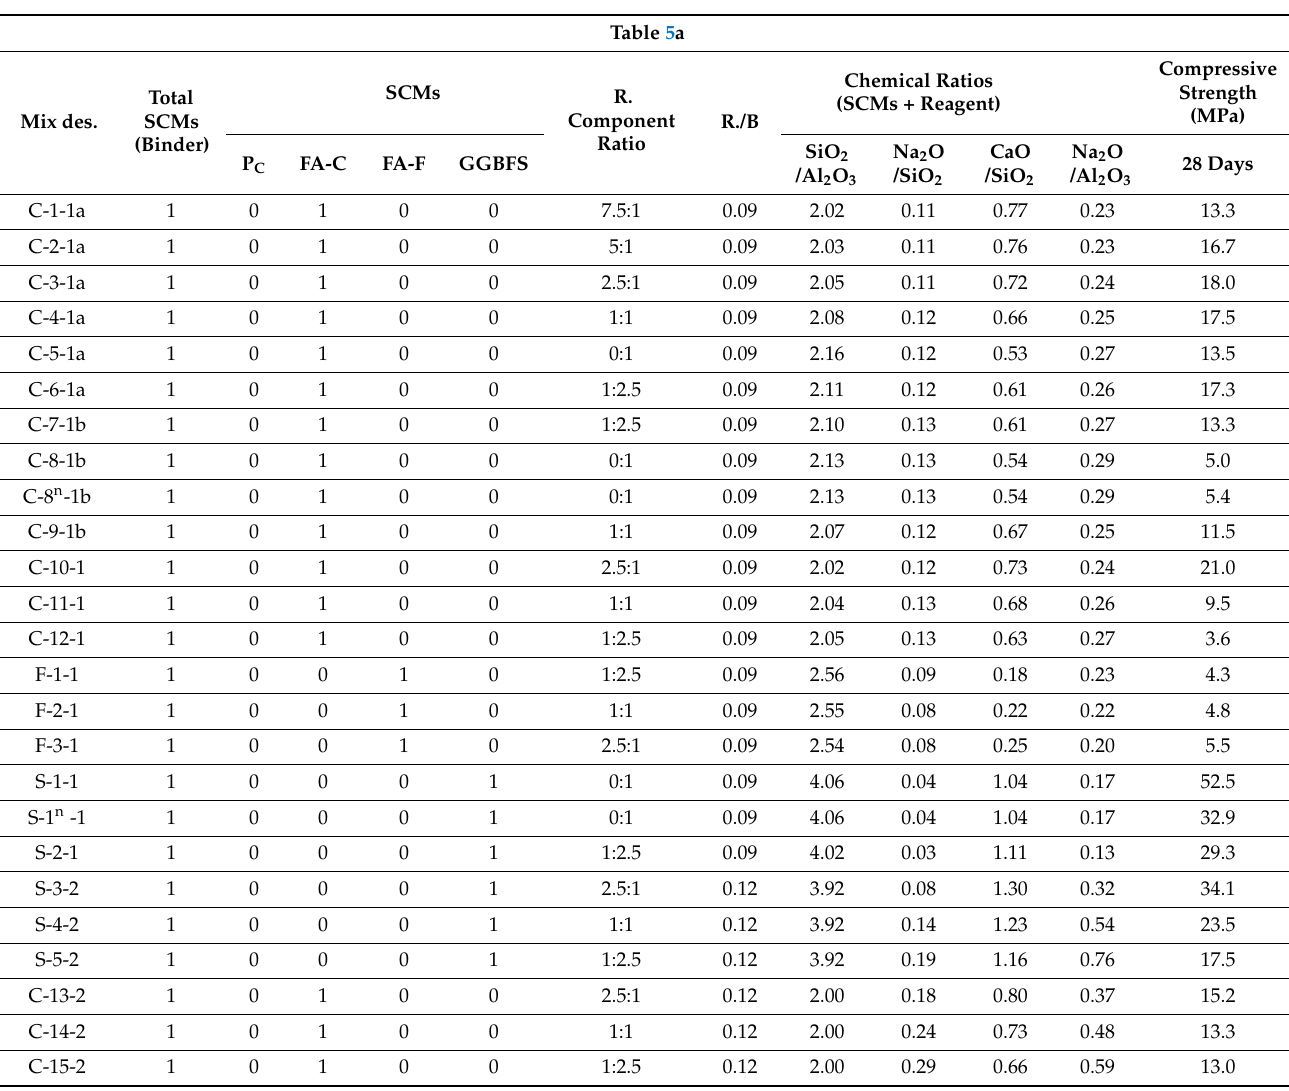
Table 5. ( a ) Mix proportions for one-part mono binders (25 mixes). ( b ). Mix proportions for one-part binary and ternary binders (18